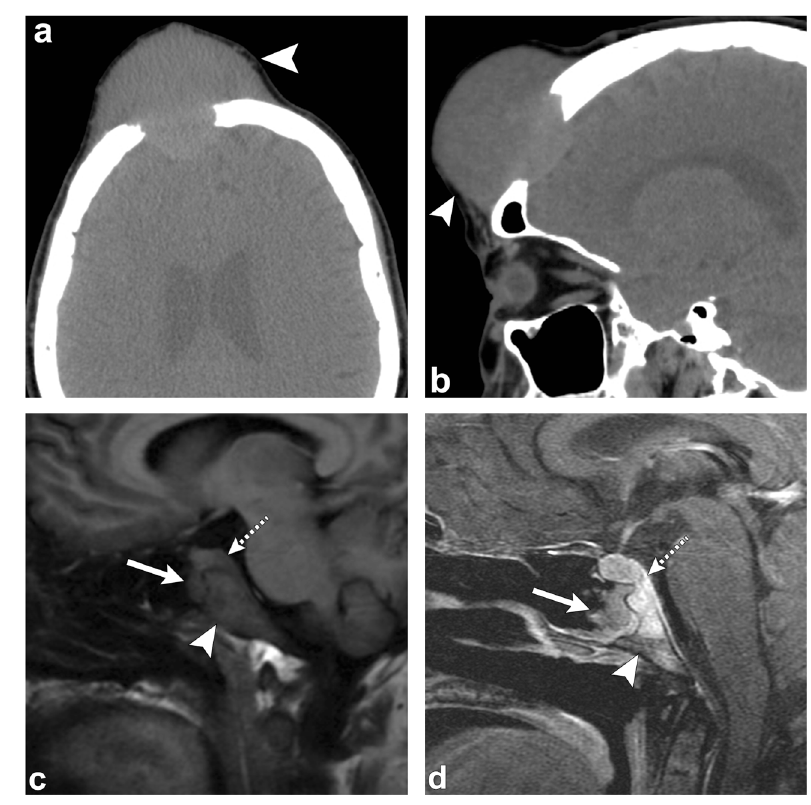
Fig. 18 Skull metastasis. Patient 1: Axial ( a ) and sagittal ( b ) head CT images show an expansile destructive lesion in the frontal skull ( arrowheads ), pathology proven metastatic renal cell carcinoma. Patient 2: Sagittal T1- weighted ( c ) and sagittal post- contrast T1-weighted ( d ) images demonstrate an enhancing lesion in the clivus ( arrowheads ) with soft tissue component extending into the sphenoid sinus ( arrows ) and anterior to the midbrain ( dashed arrow ). This lesion was proven to be metastatic from breast